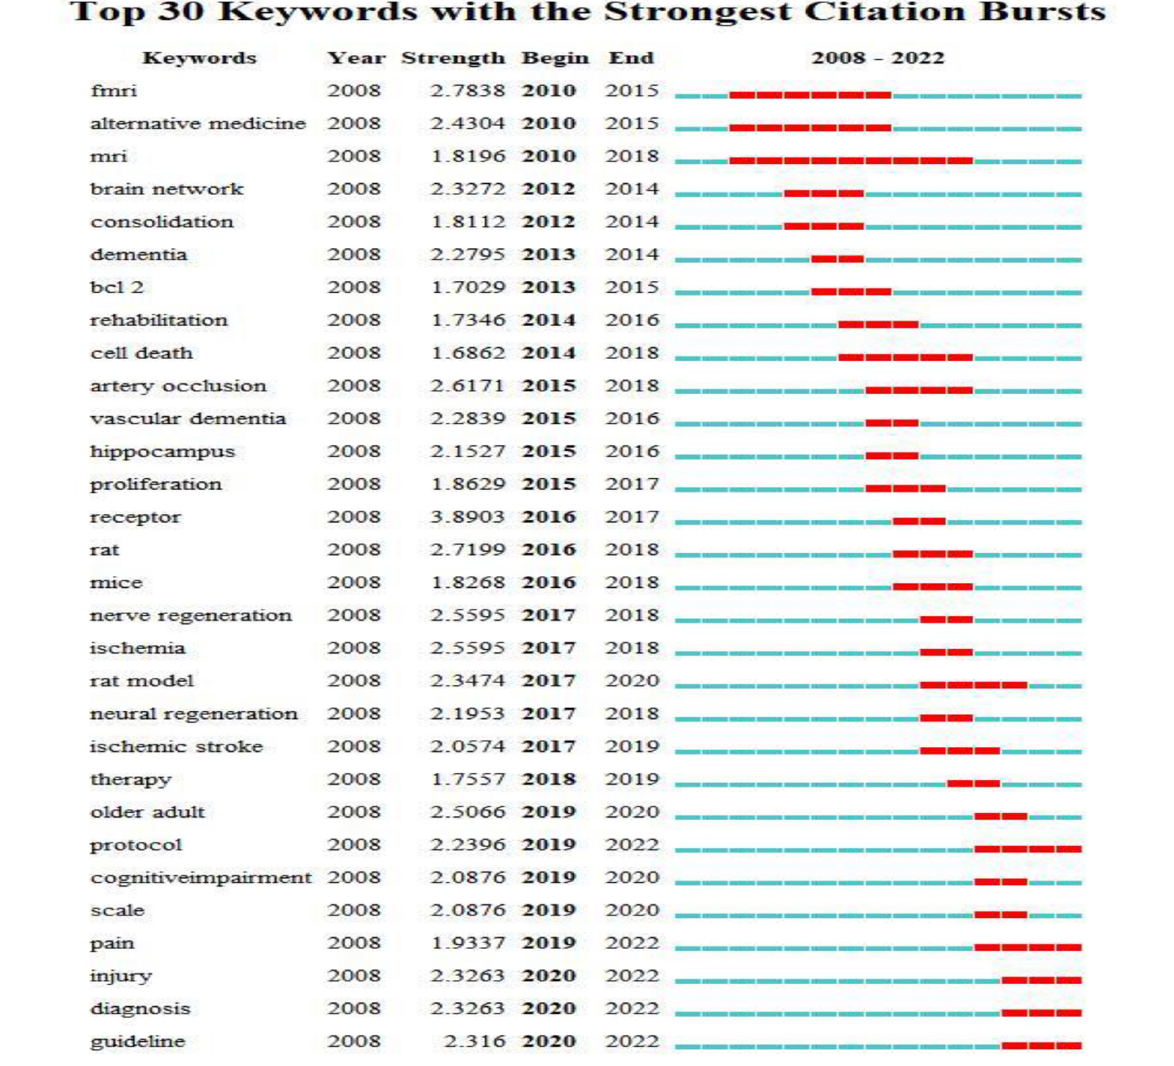
regions (Hammerschmidt et al., 2013; Yeung et al.,